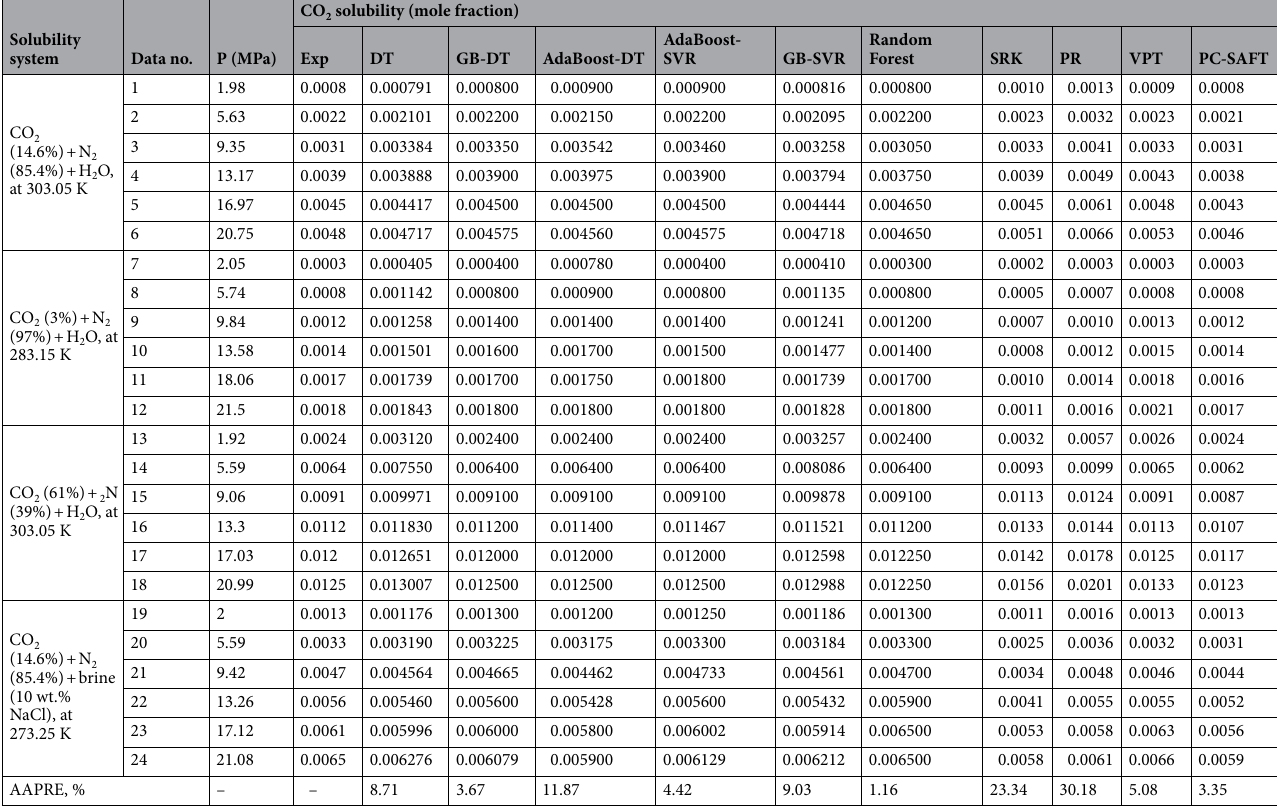
Table 6. Predictions of EOSs and smart models for CO 2 solubility in different CO 2 + N 2 + H 2 O (brine)